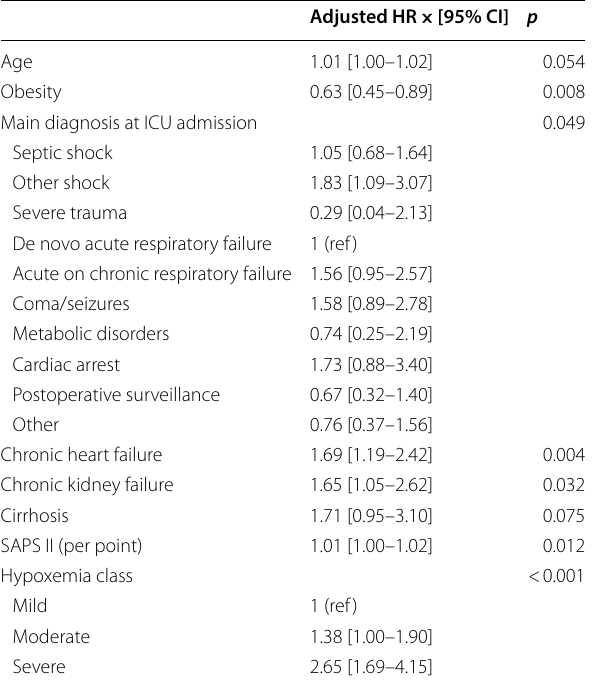
Table 5 Multivariate analysis of parameters associated with ICU